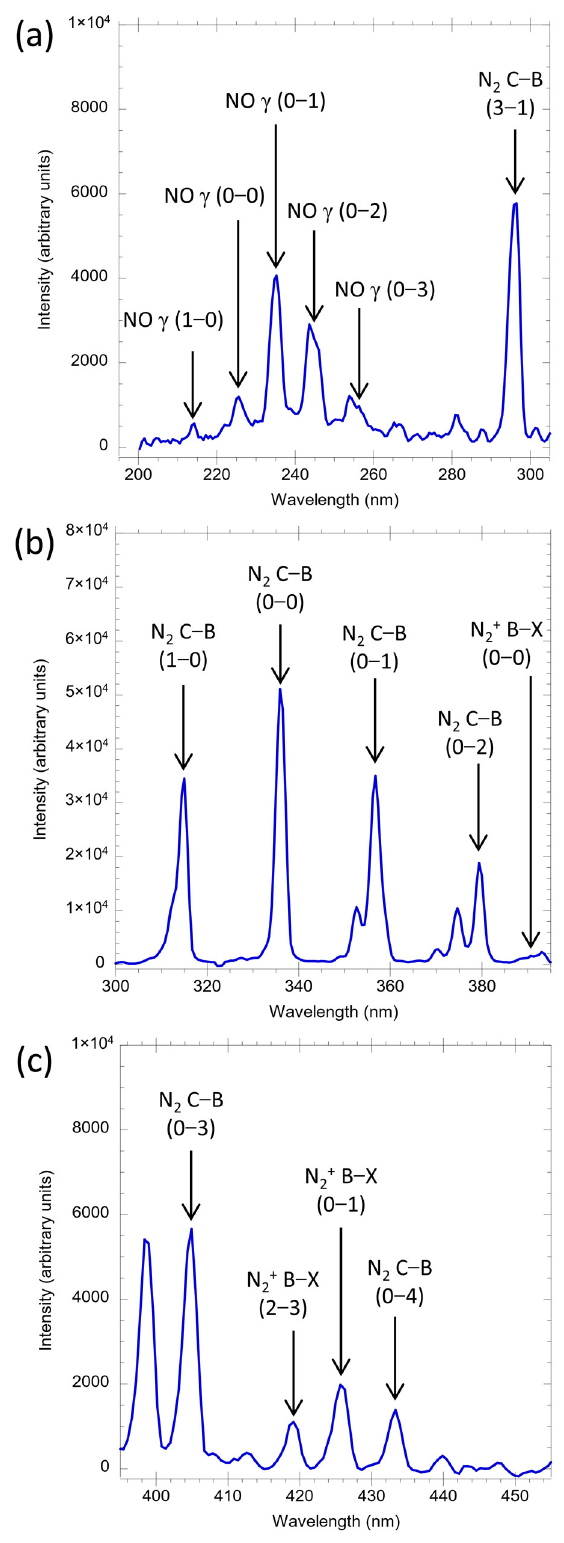
Figure 5. Typical emission spectra of the air plasma in three different UV regions: ( a ) 200–300 nm, ( b ) 300–390 nm, and ( c ) 400–450 nm. The peaks are predominantly generated by N 2